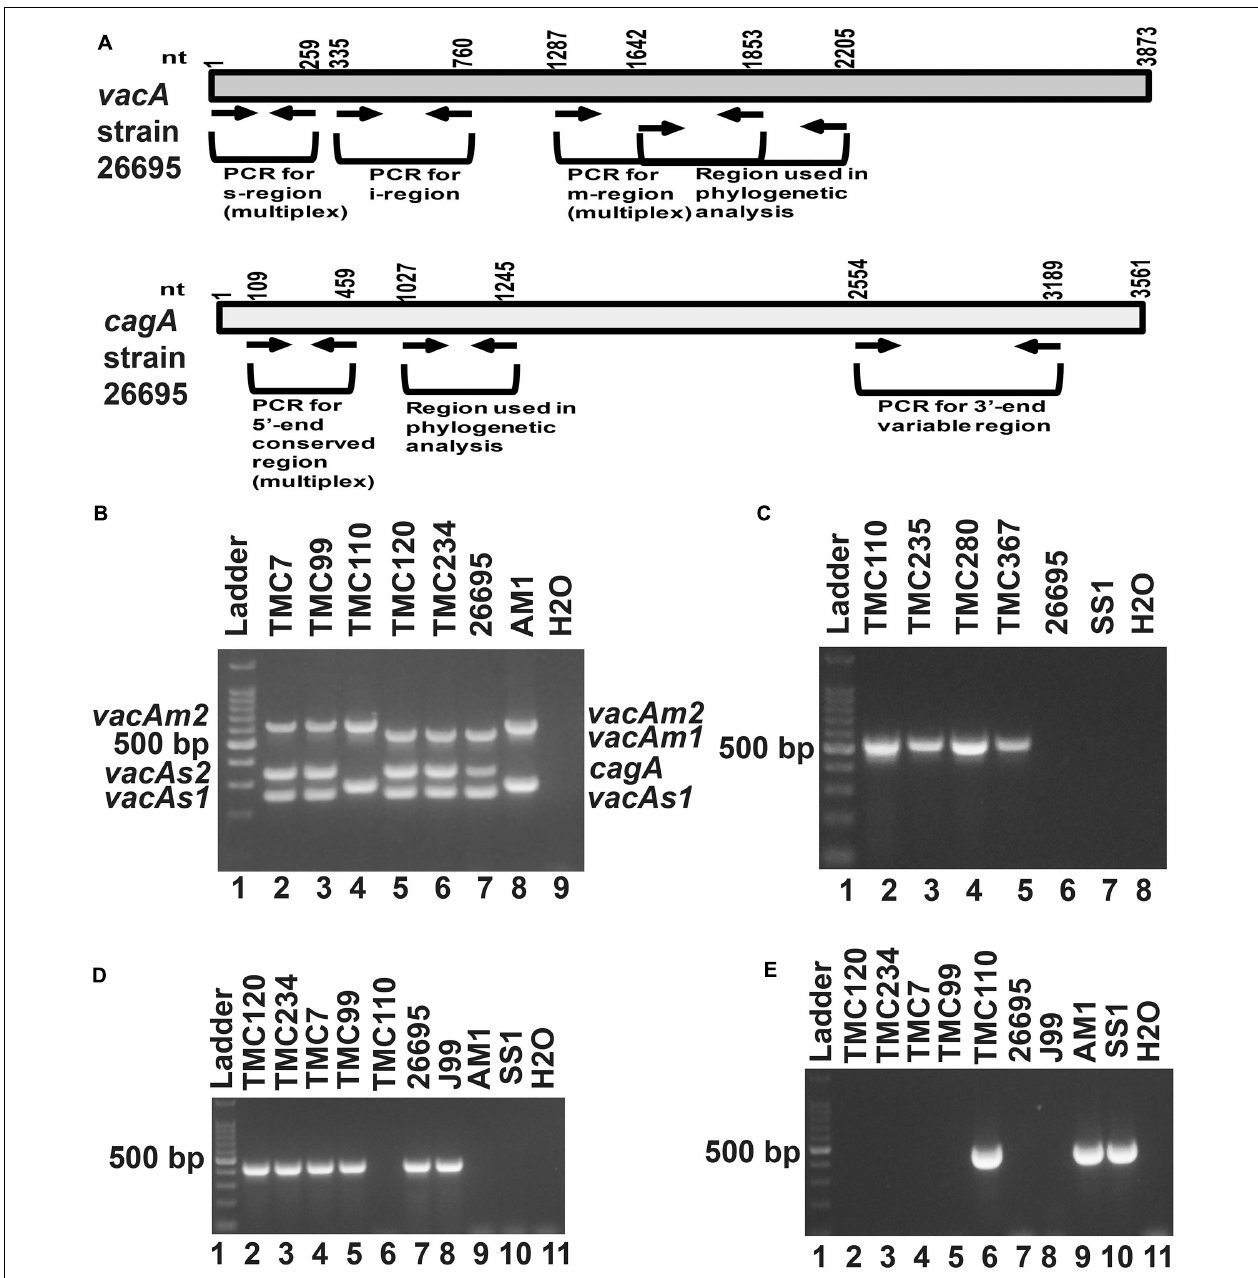
FIGURE 1 | (A) Schematic diagram of the vacuolating cytotoxin A ( vacA) and cytotoxin associated gene A ( cagA ) of the genome sequenced strain, 26,695 showing the nucleotide positions. The regions used in the analyses are indicated. (B) Multiplex PCR for genotyping the vacAs1 , vacAs2 , vacAm1 , vacAm2, and cagA of H. pylori . The strains TMC7 and TMC99 (lane 2 and 3) have vacAs1m2cagA +; the strain TMC110 (lane 4) has vacAs2m2cagA– ; the strains TMC120 and TMC234 (Lanes 5 and 6) have vacAs1m1cagA + genotypes. The strains 26,695 (lane 7) and AM1 (lane 8) were used as positive controls for vacAs1m1cagA + and vacAs2m2cagA- genotypes, respectively. Water (lane 9) was used as negative control. (C) The strains, TMC110, TMC235, TMC280, TMC367, which did not give amplicon for cagA in multiplex PCR, gave amplicon for the cag -empty site PCR. (D) PCR for the detection of vacAi1 allele. The strains TMC120, TMC 234, TMC7, and TMC99 were found to carry the vacAi1 allele, while the strain TMC110 did not give the amplicon. (E) PCR for the detection of vacAi2 allele. The strain TMC110 was found to carry the vacAi2 allele.